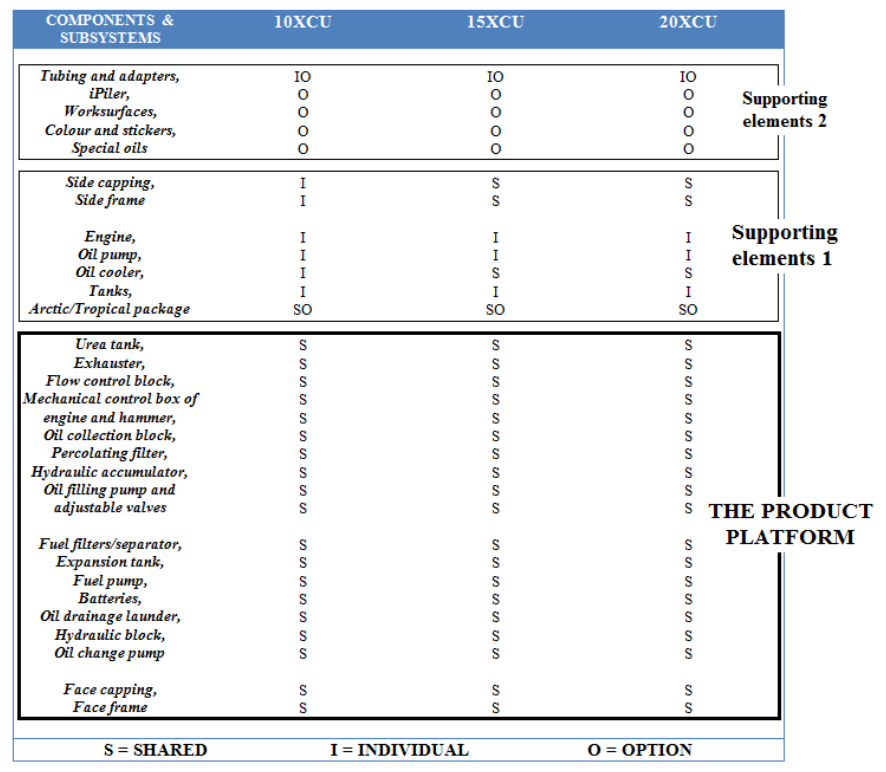
Figure 6. The X-series product platform and the supporting